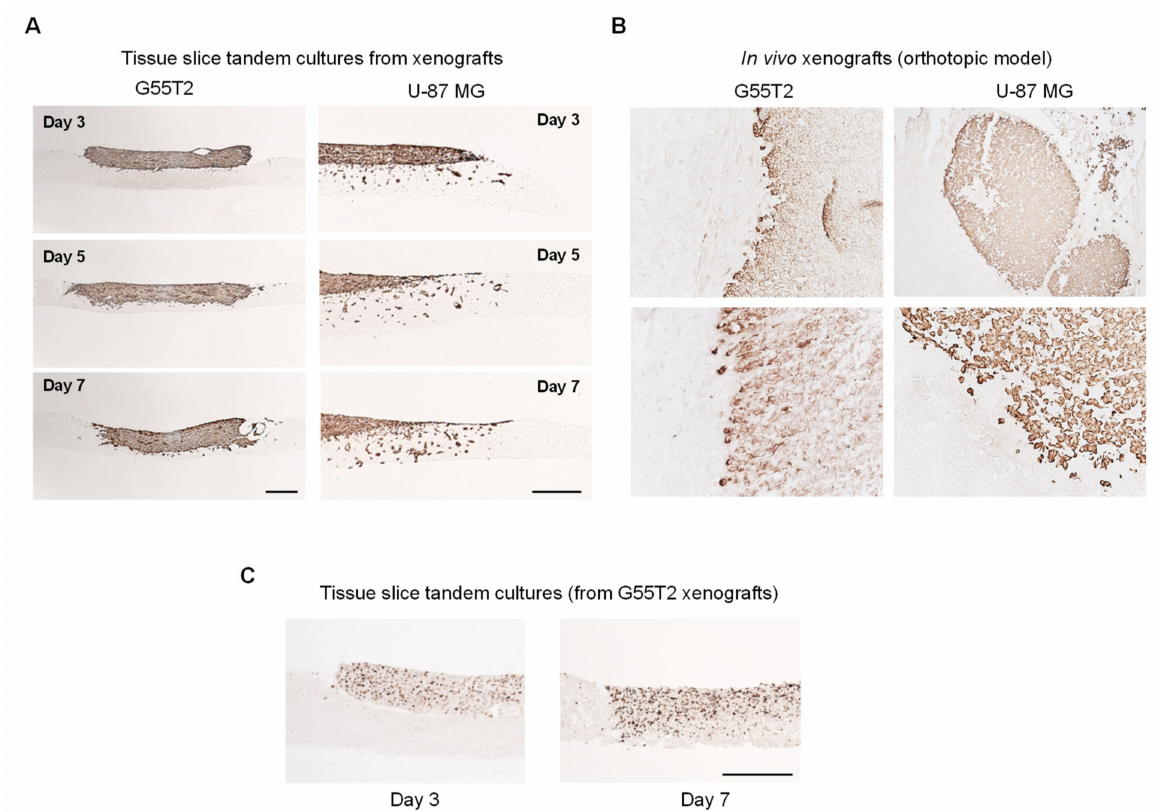
Figure 3. ( A ) Vimentin staining of time-dependent tumor growth and invasion in xenograft tandem-cultures, based on G55T2 (left) or U-87 MG cells (right). ( B ) Orthotopic xenografts based on G55T2 (left) or U-87 MG cells (right) injected into the mouse striatum, stained for Vimentin. ( C ) Proliferating cells in G55T2 xenograft tandem-cultures, as determined by Ki-67 staining. Scale bars: 200 µ